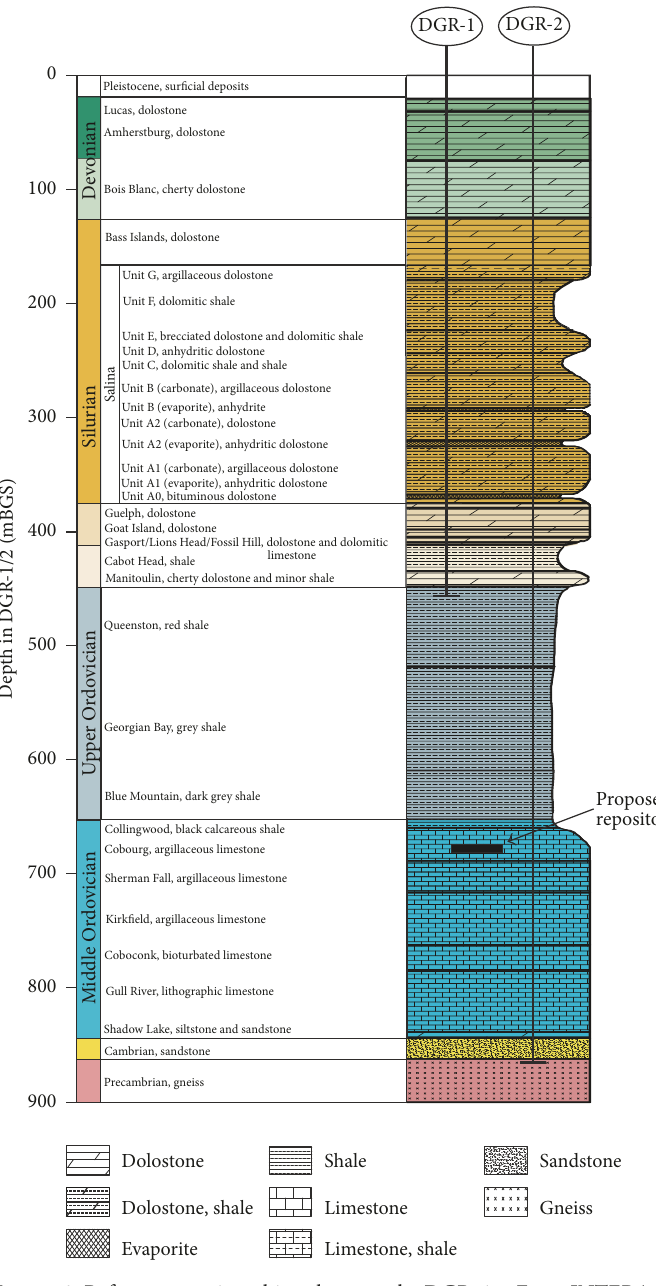
Figure 2: Reference stratigraphic column at the DGR site. From INTERA